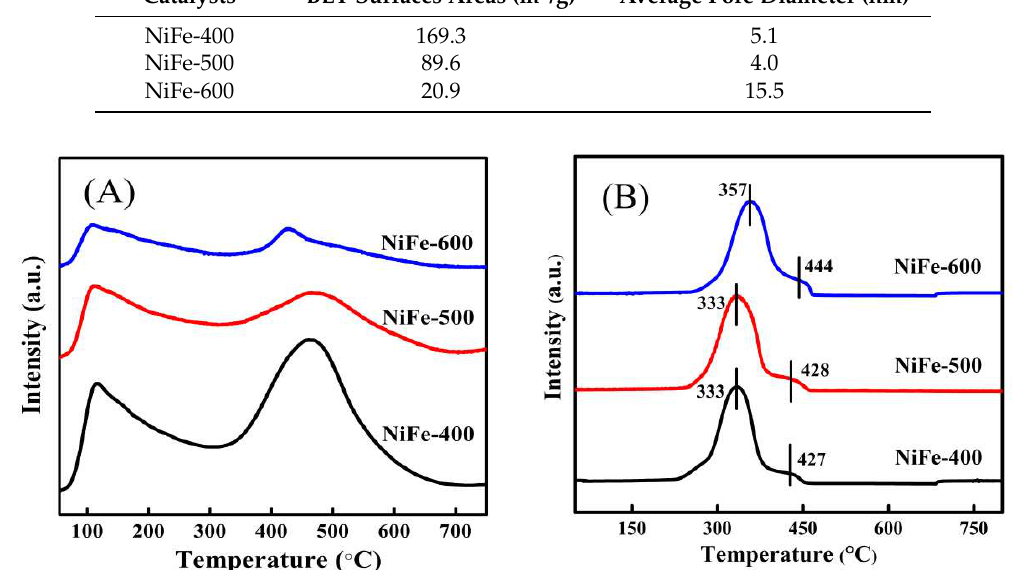
Figure 5. NH 3 -TPD profiles ( A ) and H 2 -TPR patterns ( B ) of the serial NiFe catalysts.